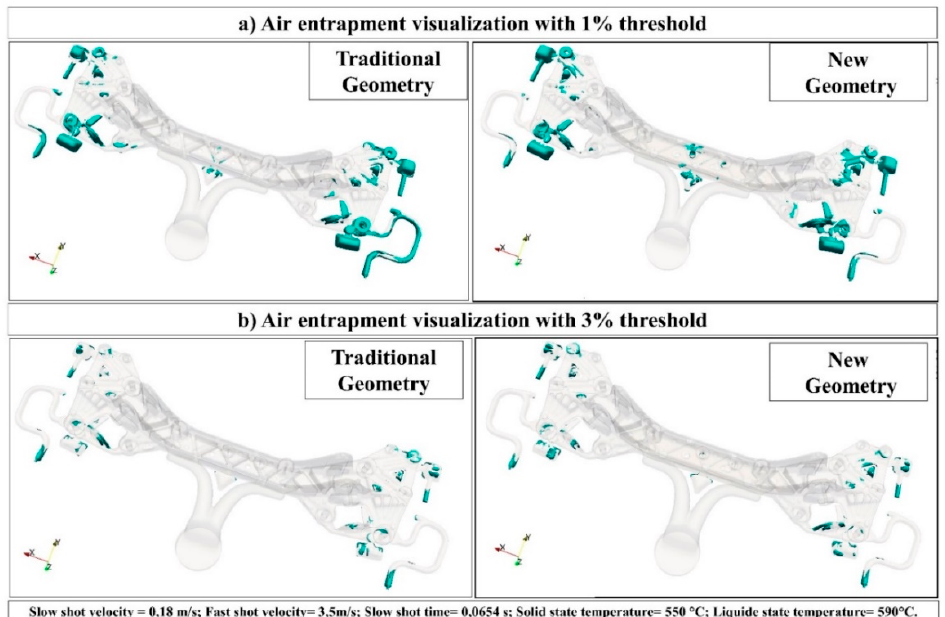
Figure 9. Air entrapment visualization ( a ) with 1% threshold and ( b ) with 3% threshold for traditional and new geometry.